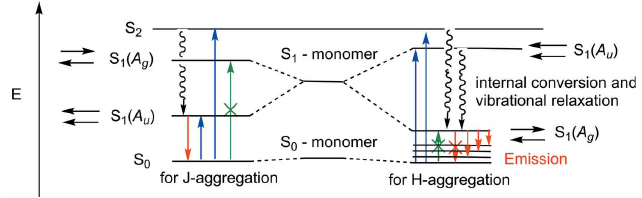
Figure 1 Jablonski diagram for H- and J-type aggregates of the (cid:2) -dimer with a centre of inversion (allowed absorption in blue, forbidden absorption in green and emission in red).